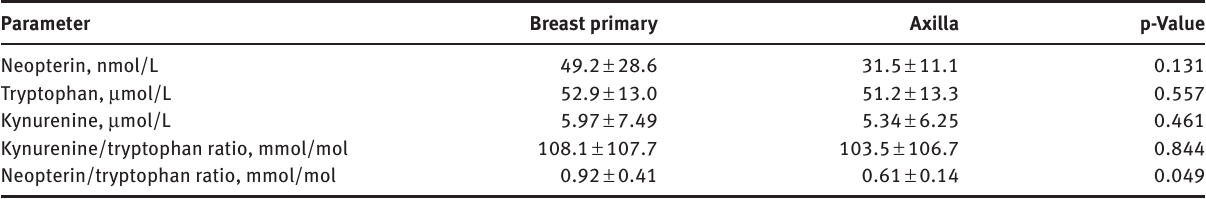
Table 2: Differences in biomarker concentrations between the wound secretions of primary tumor and axilla. Parameter Breast